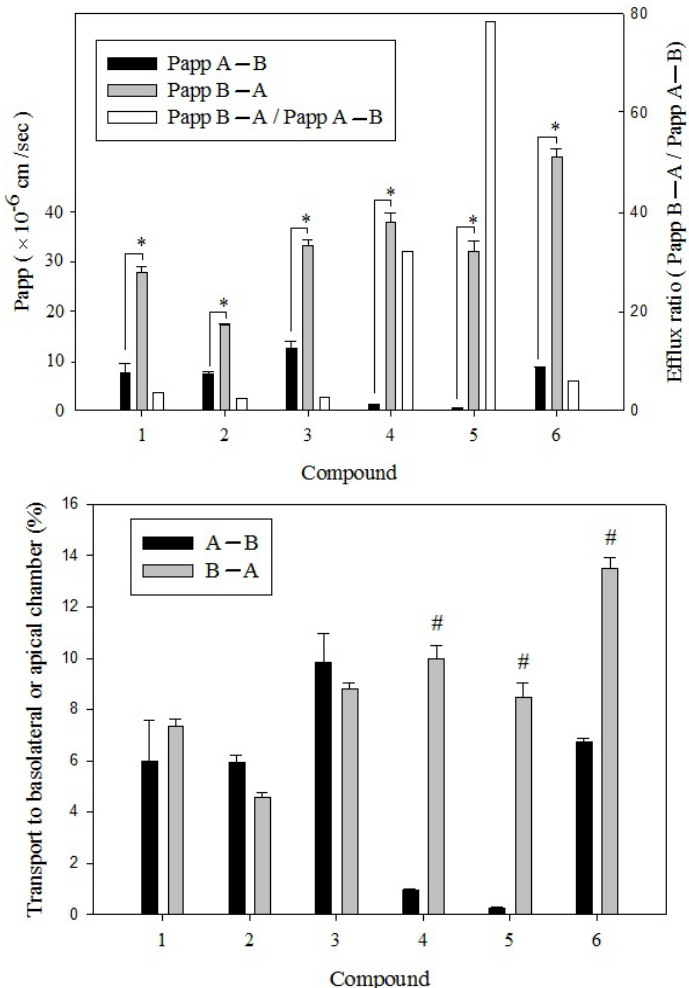
Figure 6. The apparent permeability coefficient (Papp) (upper panel) and the transport percentage (lower panel) of each compound in EM of BPR in the secretory ( B － A ) direction ( ▓ ) and in the absorptive ( A － B ) direction ( ▓ ), and the efflux ratio ( □ ). The structures and names of compounds 1–6 are referred to Figure 2. * Papp value of each tested compound in the secretory ( B － A ) direction significantly greater compared with Papp value in the absorptive ( A － B ) direction ( p < 0.05). # Transport of each compound in EM of BPR in the secretory ( B － A ) direction significantly greater compared with in the absorptive ( A － B ) direction ( p <